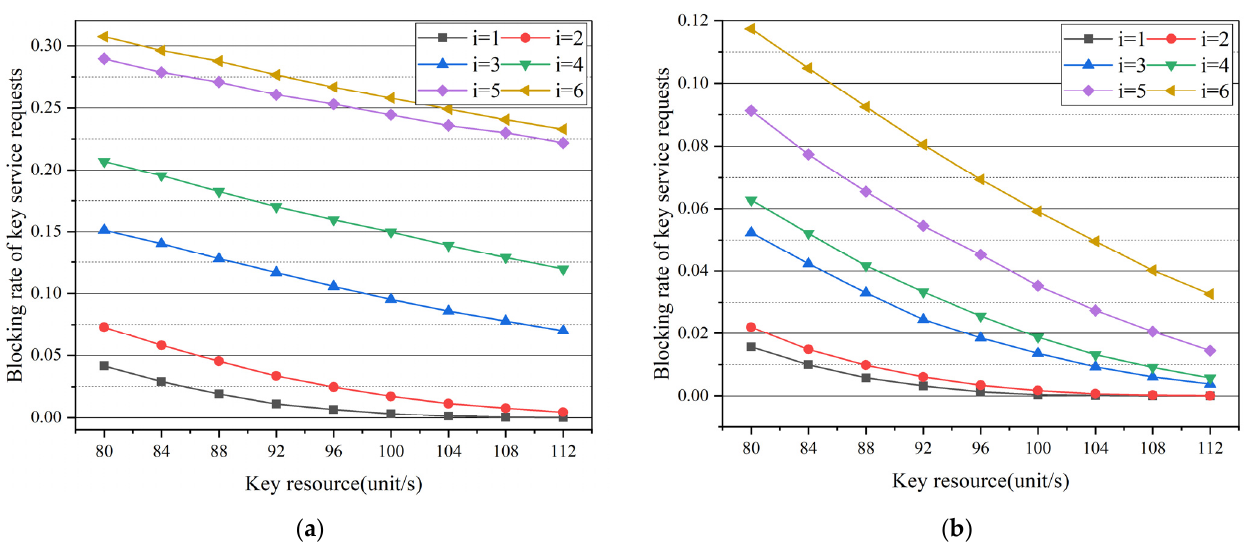
Figure 7. Simulation results: ( a ) blocking rate of key service requests varies with key resource in the case of different untrusted node numbers in NSFNET; ( b ) blocking rate of key service requests varies with key resource in the case of different untrusted node numbers in USNET.